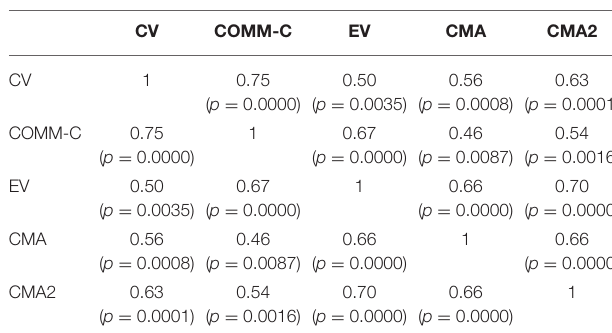
TABLE 2 | Correlations (Spearman coefficients) between the 5 tasks in Experiment 1.